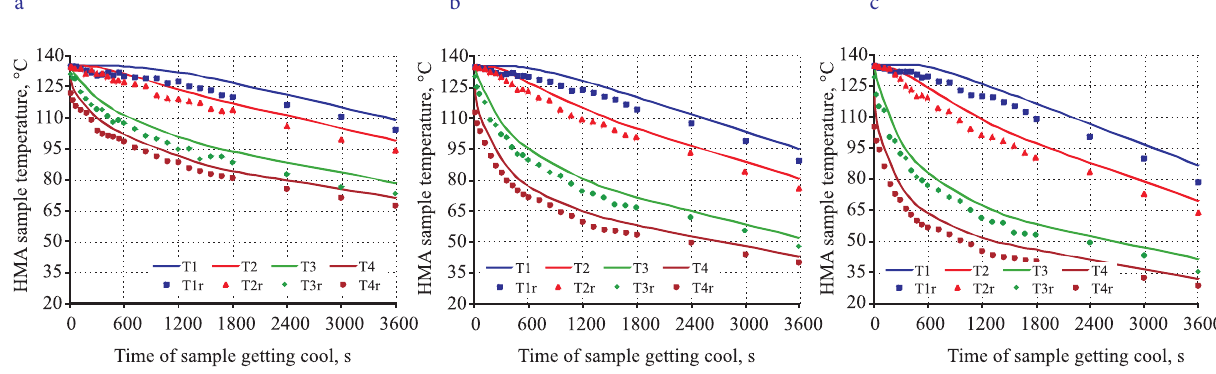
Fig. 3. The theoretical temperature, and that measured in S1 sample, 5 cm thick in the temperature of 0 °C: a – without wind; b – with wind 8 m/s; c – with wind 16 m/s; T1, T2, T3, T4 – theoretical temperature corresponding to being located in the layer in accordance to drawing 2; T1r, T2r, T3r, T4r – temperature measured in places as on